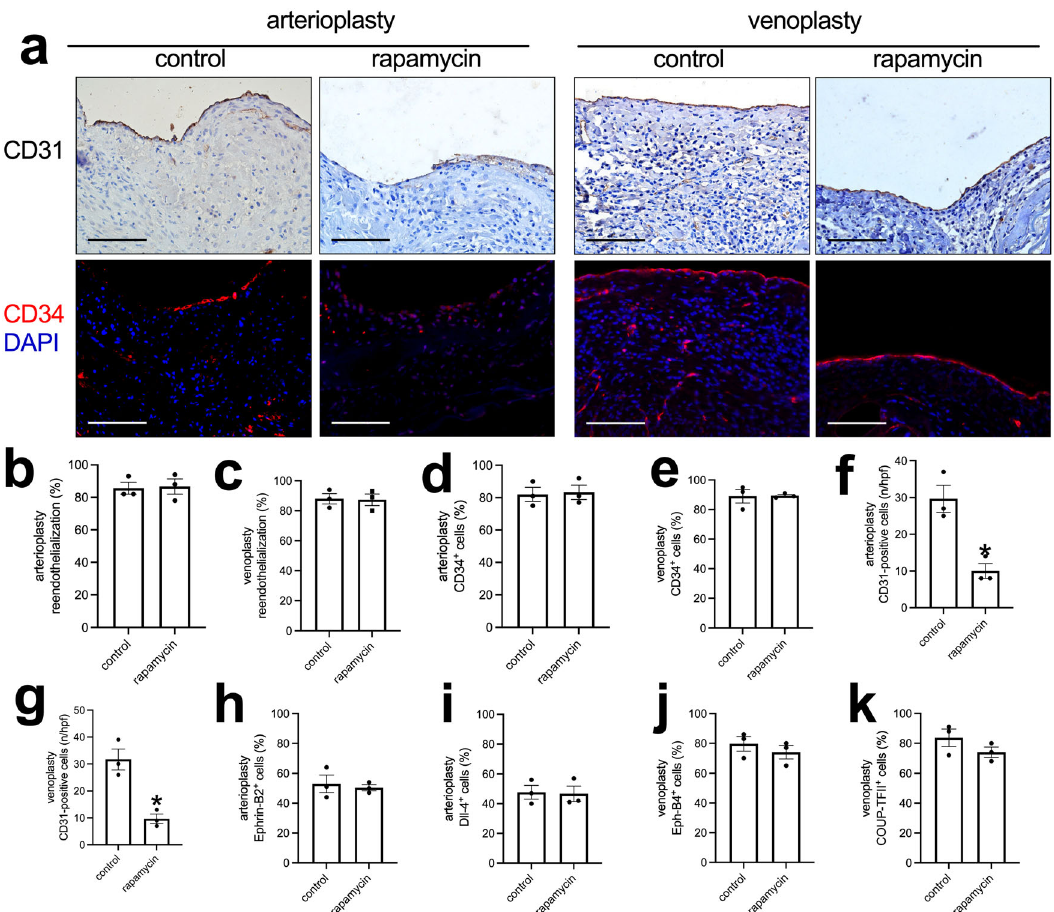
Fig. 4 Endothelial cell identity in the control or rapamycin-coated patches harvested from aorta arterioplasty or IVC venoplasty, day 14. a First row, Photograph of immunohistochemistry stained for CD31; second row, and photograph of the immuno fl uorescence merge of CD34 (red) and DAPI (blue) of the neointima; scale bar, 100 μ m, n = 3. b , c Bar graphs showing neointimal reendothelialization of the arterioplasty ( p = 0.8744) and venoplasty ( p = 0.9037), day 14; t -test; n = 3. d , e Bar graphs showing the neointimal CD34-positive cell coverage in the arterioplasty ( p = 0.8416) and